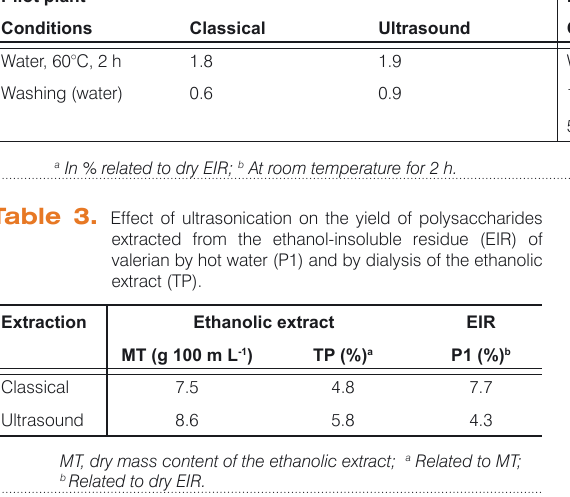
Figure 1. Schematic structure of some xylan-type hemicelluloses depicting the substituents and their sites of attachment to the xylan backbone. MGX, 4-O-methylglucuronoxylan; AGX, (arabino)glucuronoxylan; GAX,